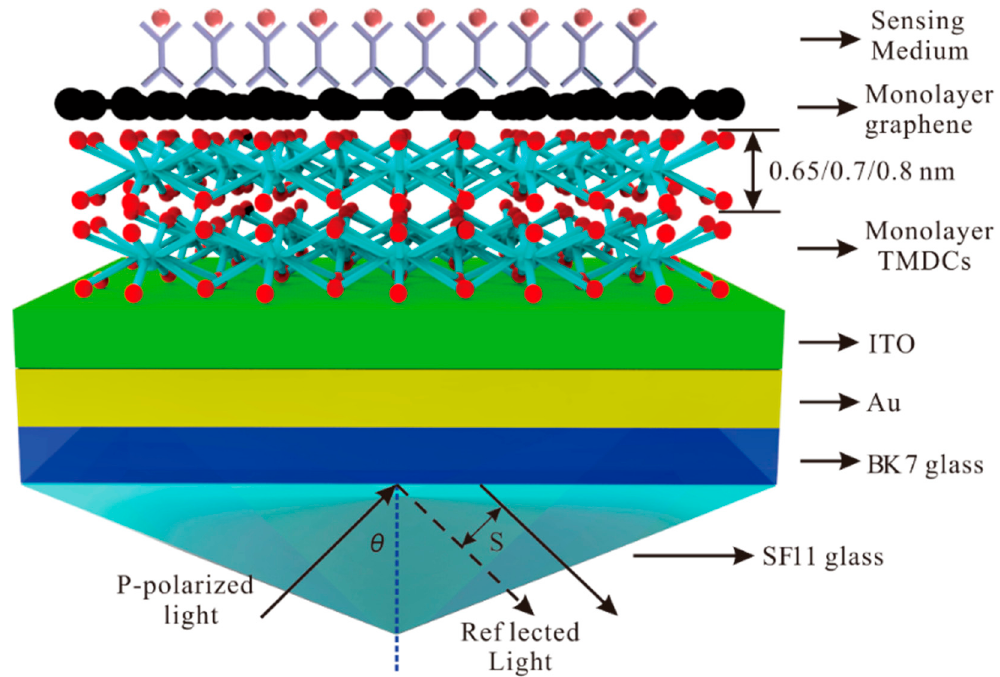
Figure 1. The Kretschmann configuration with the TMDCs-graphene hybrid structure coated indium tin oxide (ITO) and Au thin film for surface plasmon excitation.